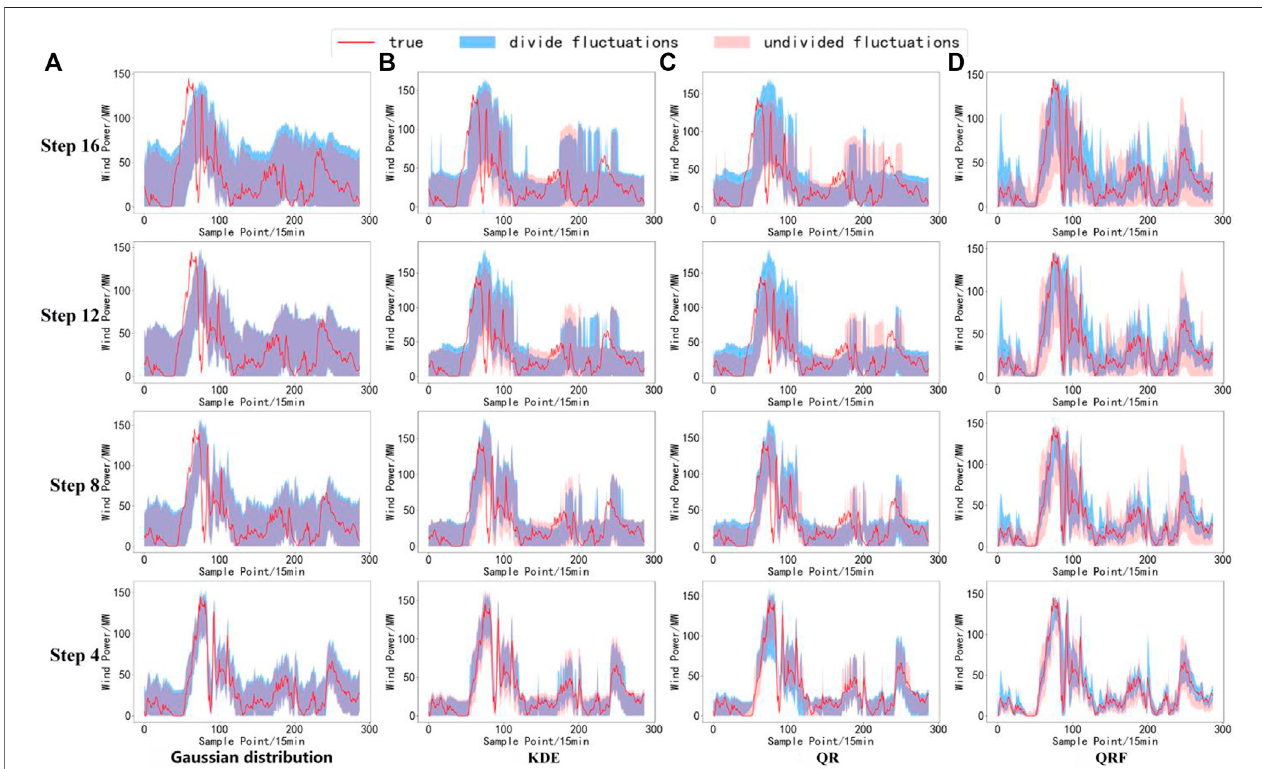
FIGURE 7 | A comparative analysis of whether the four methods have been divided by volatility (From left to right, Gaussian distribution, KDE,QR,QRF) the labels (A – D) is the interval prediction effect diagram of four methods.